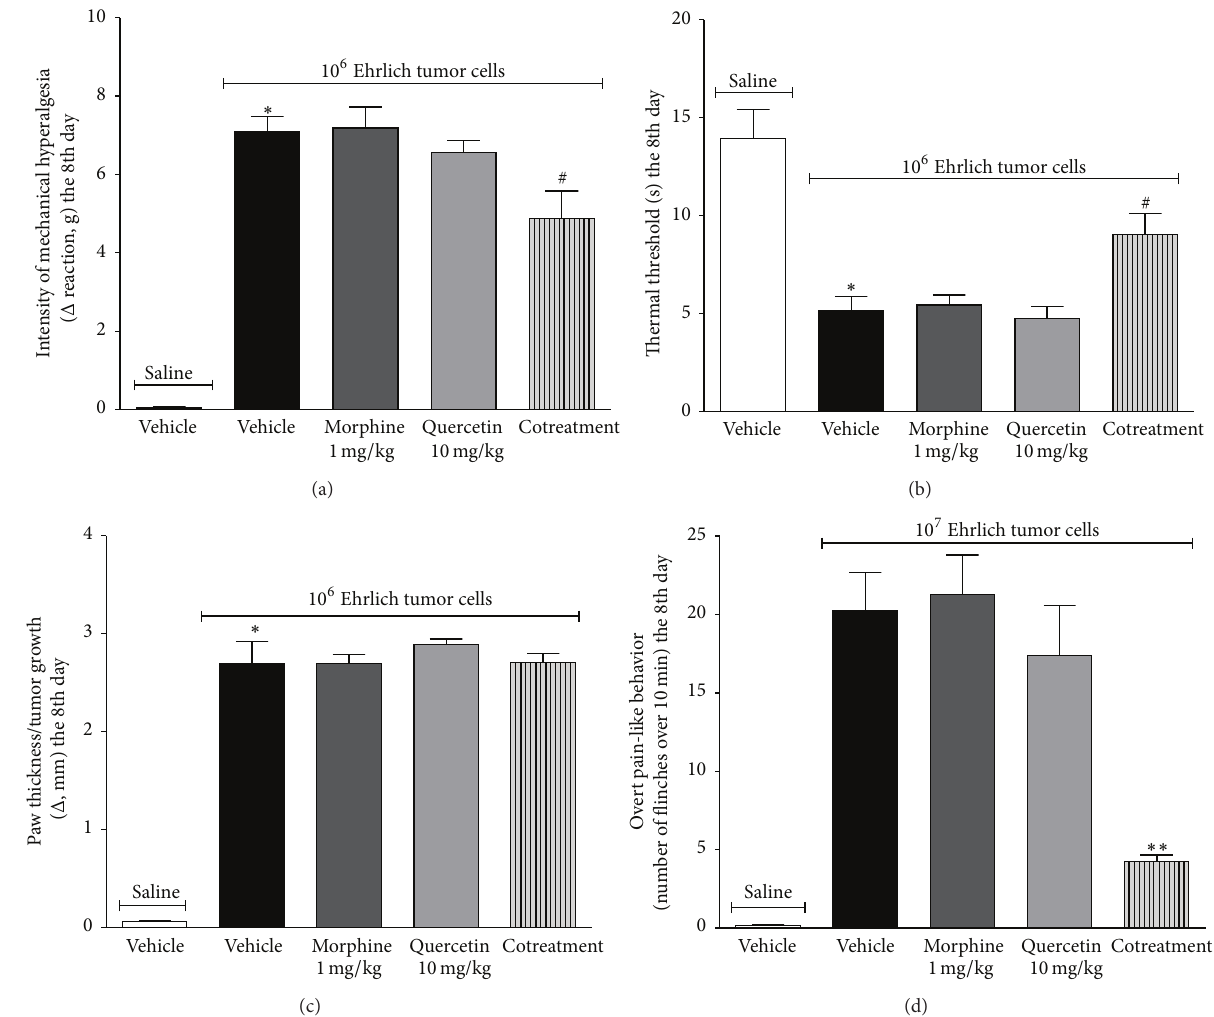
Figure 11: Combined treatment with quercetin and morphine at doses that are ineffective as single treatment reduces Ehrlich tumor-induced pain-like responses. Mice were treated with quercetin (10mg/kg i.p., a dose without significant analgesic effect per se ), before the injection of Ehrlich tumor cells (1 × 10 6 or 1 × 10 7 cells, i.pl.). Mice were treated daily during 8 days and, in the 8th day, mice were treated with quercetin and after 2 h and 15min received morphine (1mg/kg i.p., a dose without significant analgesic effect per se ). Mechanical (a) and thermal hyperalgesia (b), paw thickness (c), and overt pain-like behavior (d) were evaluated 3 h after the last quercetin treatment. Data are presented as means ± SEM of six mice per group per experiment and representative of two separated experiments: ∗ 𝑝 < 0.05 compared to the saline group, # 𝑝 < 0.05 comparedtothetumorgroup,and ∗∗ 𝑝 < 0.05 comparedtothequercetin10 mg/kgandmorphine1 mg/kg.One-wayANOVA followed by Tukey’s